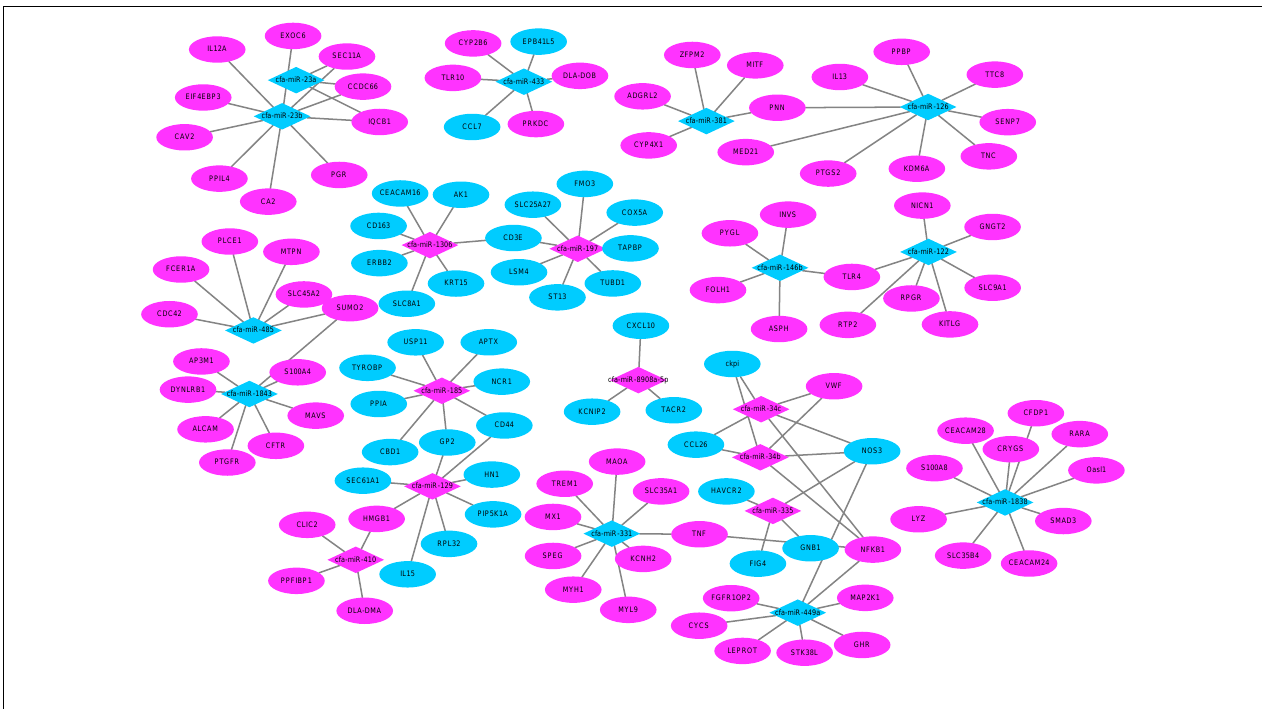
FIGURE 8 | MiRNA–mRNA negative correlation network. Red indicates up-regulation and green indicates down-regulation. TABLE 1 | Relative miRNA expression of selected differentially expressed genes (DEGs) as revealed through miRNA-Seq and quantitative real-time PCR